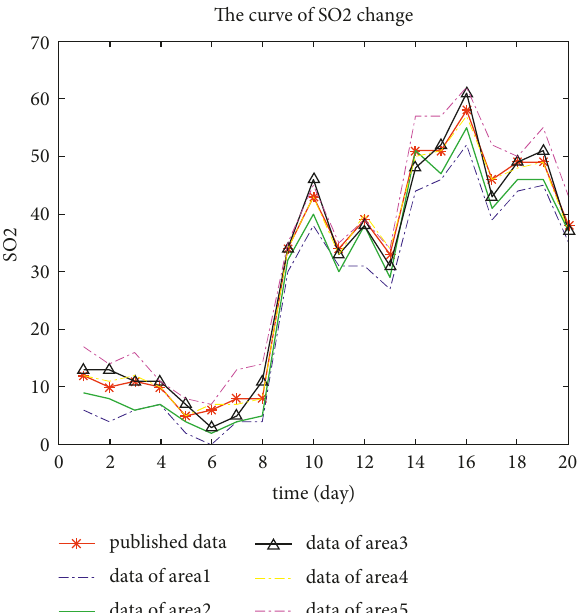
Figure 7: Curve of SO 2 change in different task grid areas.